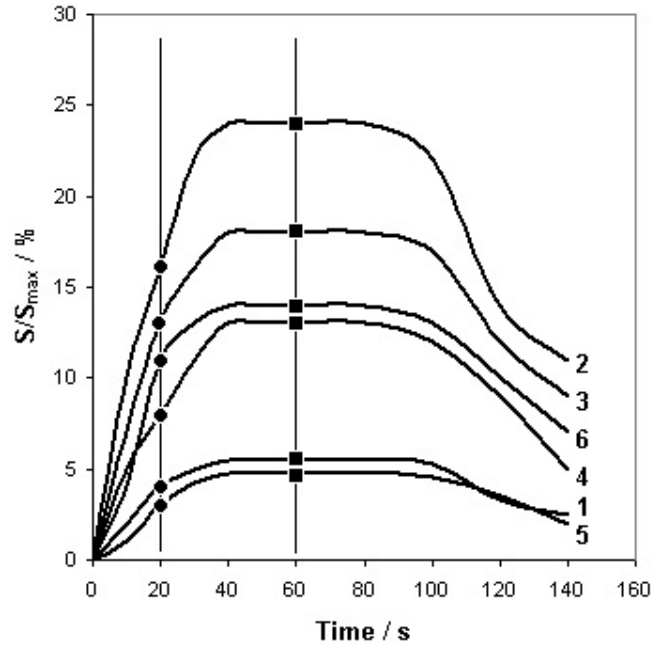
Figure 3. Dependence between sensor signals and barbotage time for A 5 type